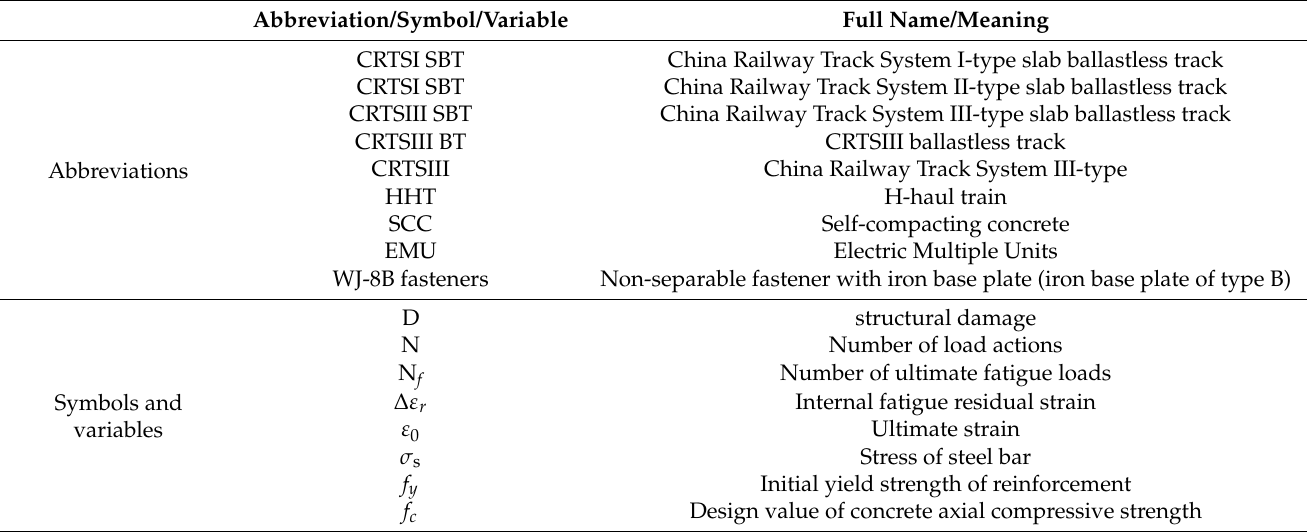
Table 1. Abbreviations, Symbols and